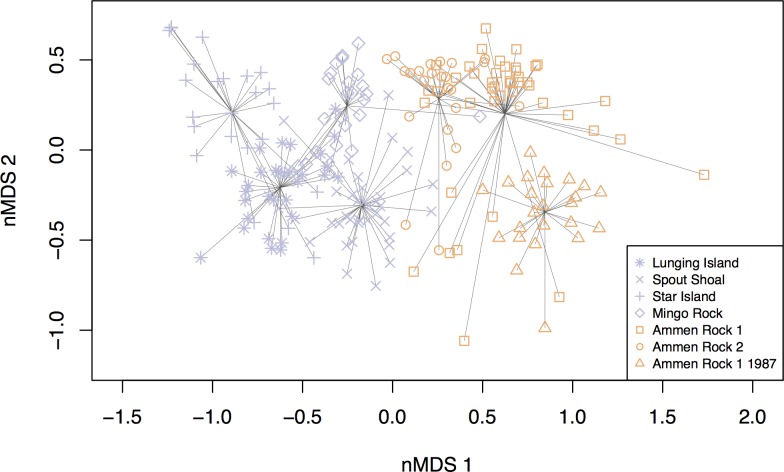
nMDS plot indicating differences in benthic community structure (sessile invertebrates, understory algae) between coastal and offshore sites on Cashes Ledge (Ammen Rock 1, 2, Ammen Rock 1 1987).Note the spatial segregation between coastal sites (colored purple) and offshore sites (colored orange), and the shift in the composition of the benthic community at the Ammen Rock sites between 1987 and 2015, when Ammen Rock 1 and 2 sites were sampled. Each individual data point represents the benthic community sampled in a 0.25 m2 quadrat. Replication consisted of the following number of photo quadrats per site: LI 31, SS 24, SI 24, MR 38, AR1 43, AR2 24 and AR1 1987 24.